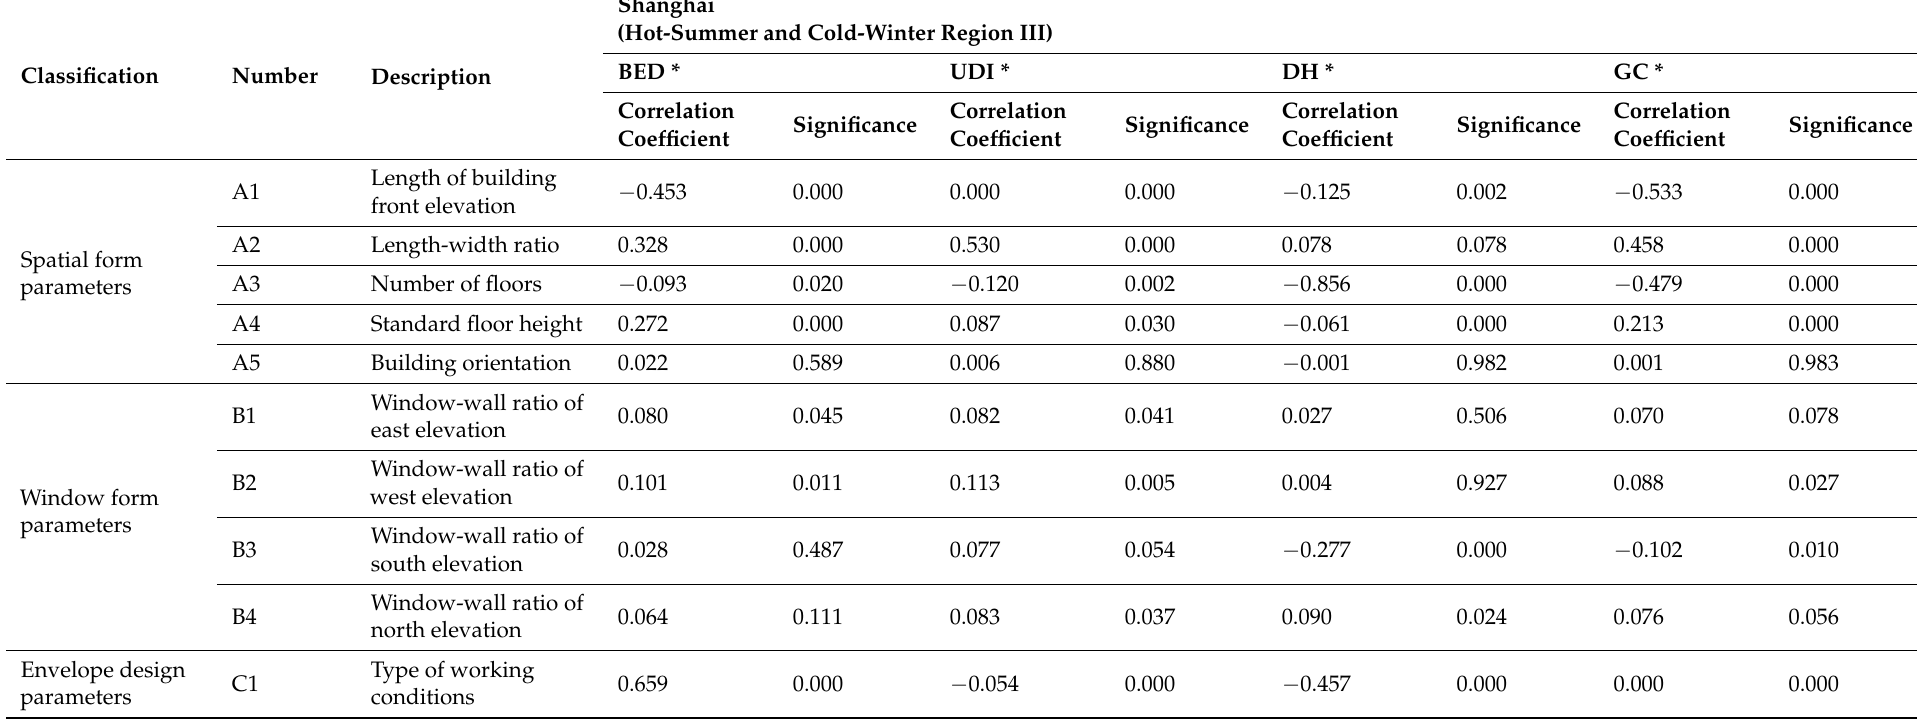
Table 10. Comparison of Spearman’s rank correlation coefficient of the design parameters of building forms in